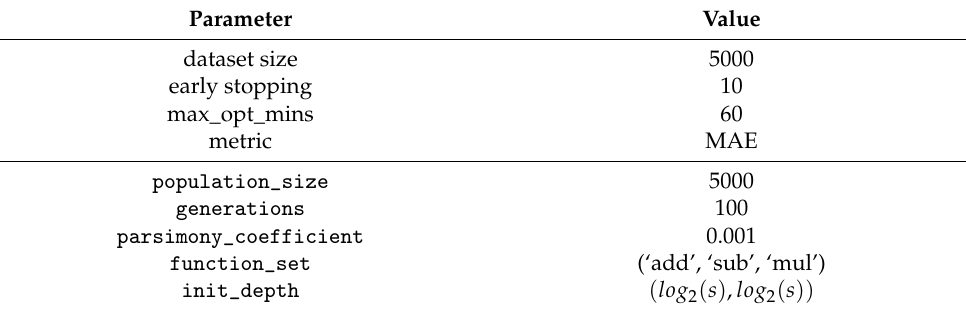
Table A1. Parameter settings for symbolic